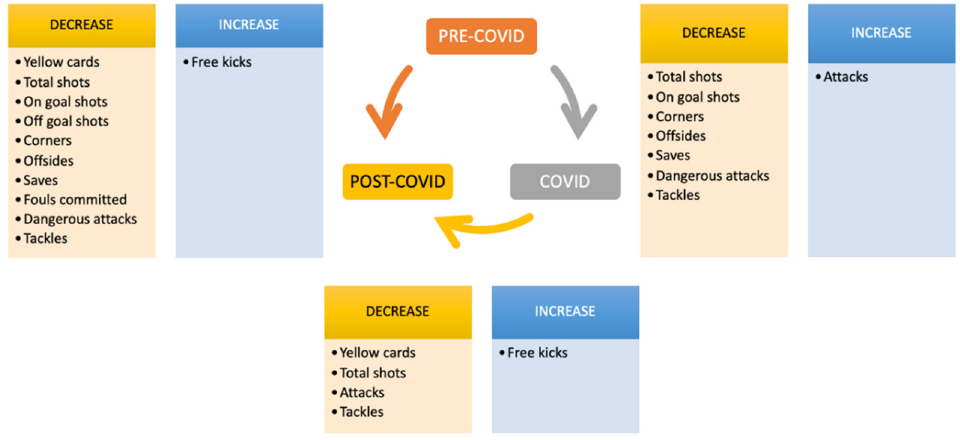
Figure 1. Influence of COVID on PIs.